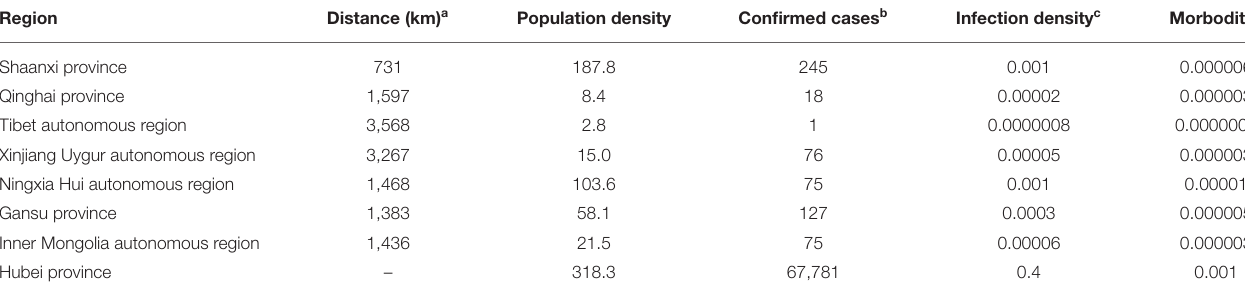
TABLE 1 | The population and geography features of seven provinces or autonomous regions in Northwestern China. Region